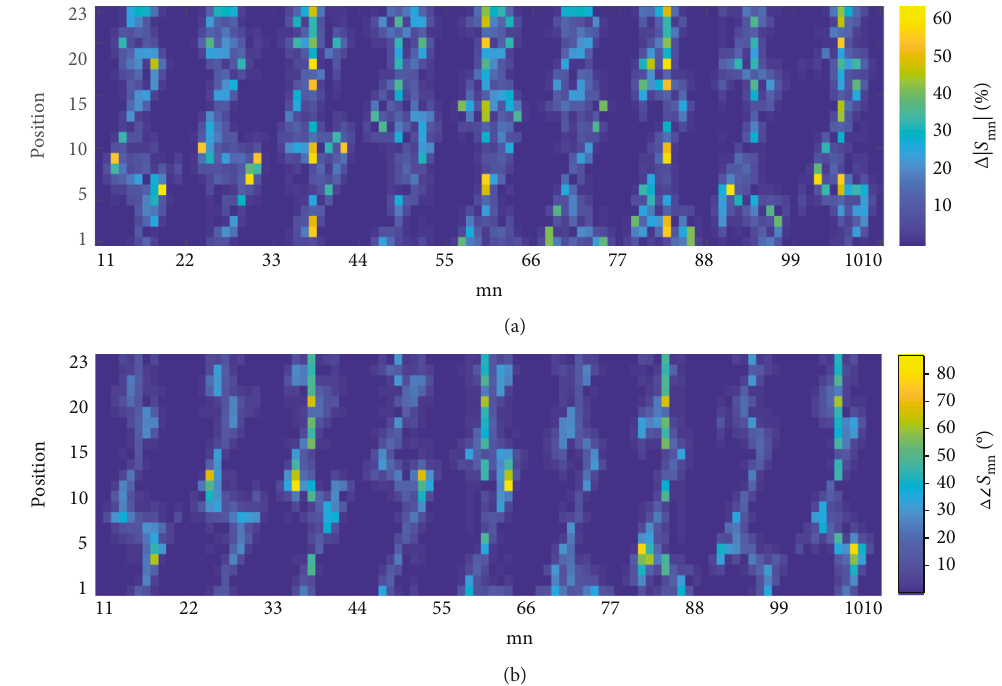
Figure 4: Response of the system ((a) relative change in the modulus of S-matrix and (b) change in the phase of S-matrix in degrees) to a presence of the hemorrhagic stroke phantom at 23 di ff erent positions ( y axes) in the phantom of human